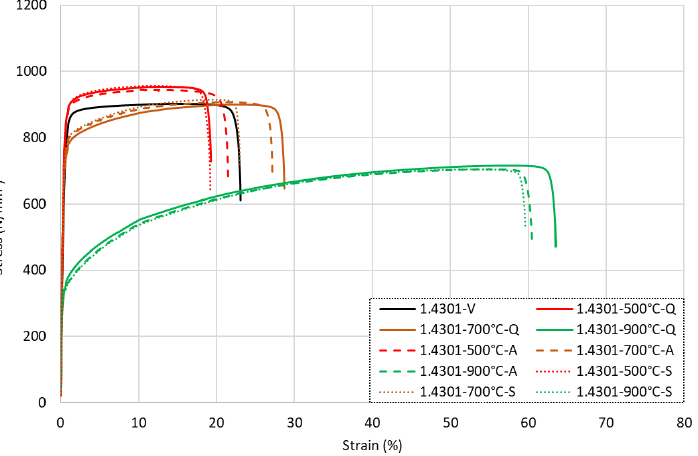
Figure 5. Stress – strain responses for grade 1.4301 stainless steel rebars following exposure to 500 °C, 700 °C, and 900 °C and various